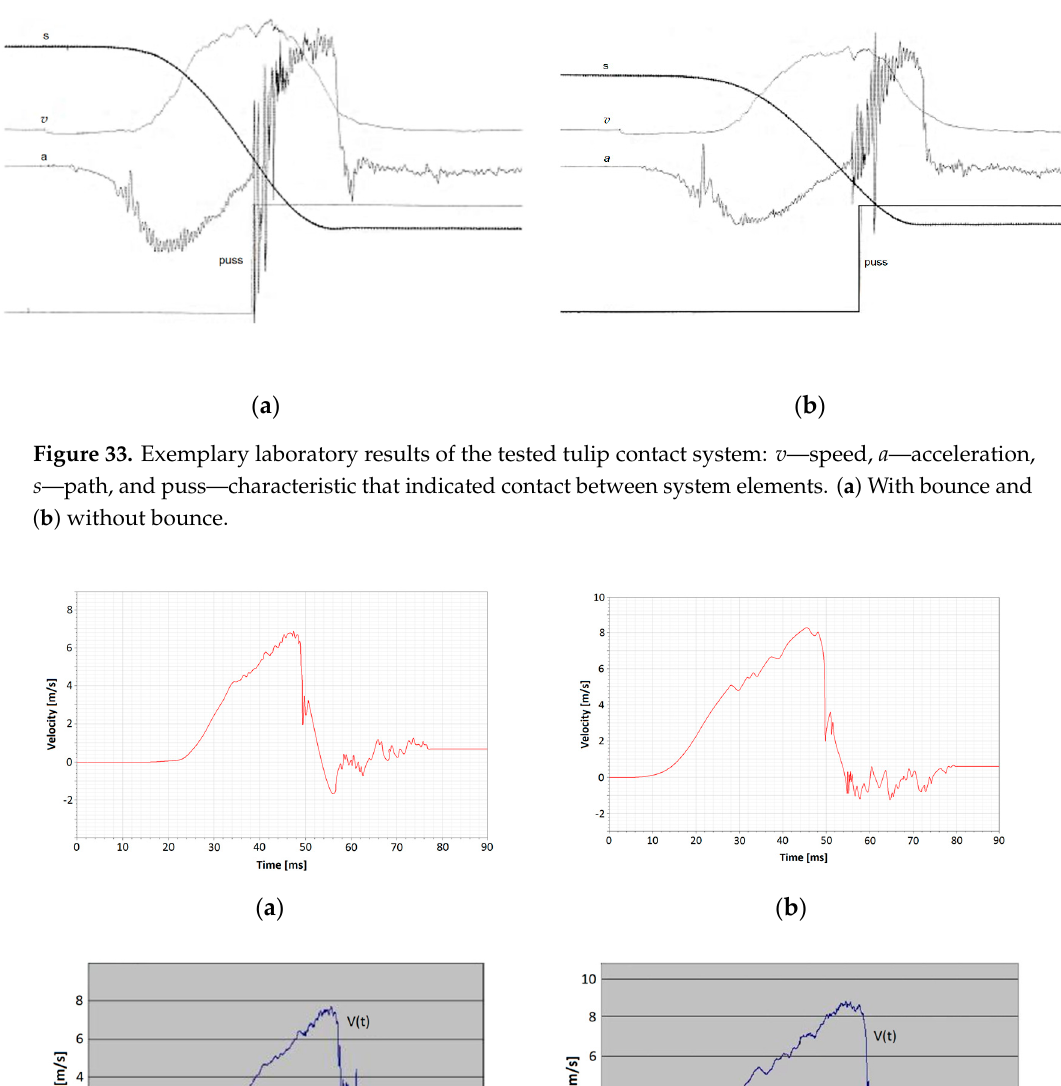
Figure 33. Exemplary laboratory results of the tested tulip contact system: v —speed, a —acceleration, s —path, and puss—characteristic that indicated contact between system elements. ( a ) With bounce and ( b ) without bounce.